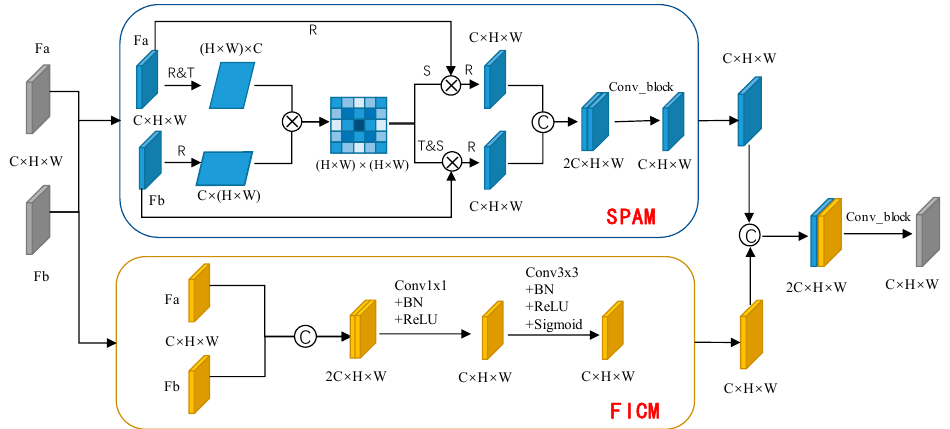
Figure 3. Change analysis module.